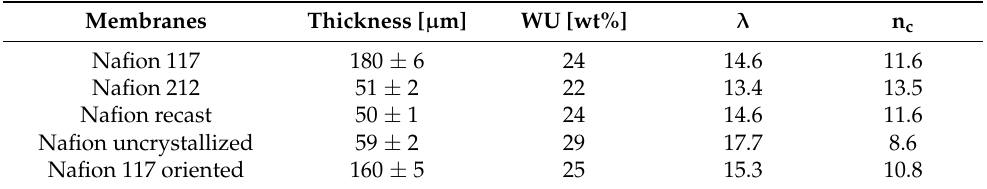
Table 2. Thickness, WU%, lambda, and nc for Nafion 117, NR212, “recast”, “uncrystallized” and “oriented” at 25 ◦ C in liquid water for 24 h.